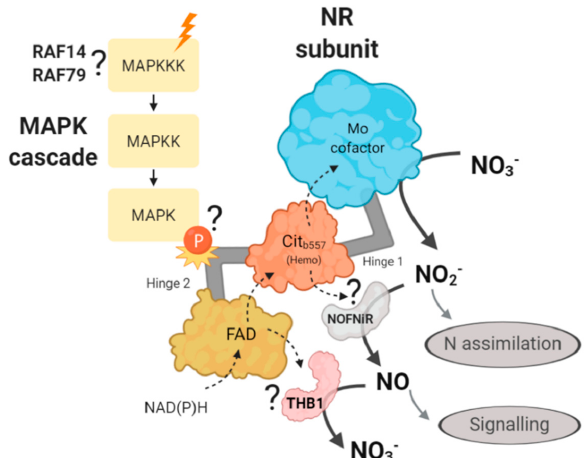
Figure 12. Illustration of the hypothetical mechanism proposed about the role of the MAPK cascade in the regulation of nitrate reductase. The di ff erent N sources (orange ray) would activate a MAPK signaling cascade that would ultimately cause the phosphorylation of NR, probably in the hinge region 2. This would activate / inhibit the binding of NOFNiR or THB1, which would control the reduction of nitrite to NO, and would act as a signaling molecule. With our data we propose RAF14 and RAF79 as candidates to sense the N signal. The question mark indicates that such interactions have not been experimentally demonstrated yet. The dotted arrows represent the movement of electrons and the solid arrows the substrate and product of each